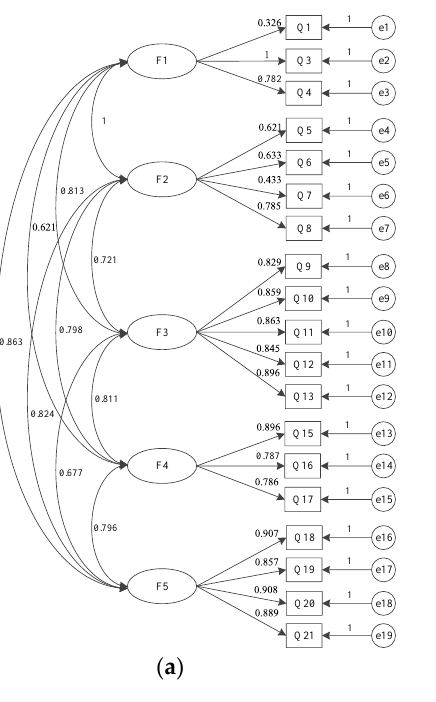
Figure 3. ( a ) Pre-model ( b ) After-model. Table 7. Model fitting results. Table 7. Model fitting